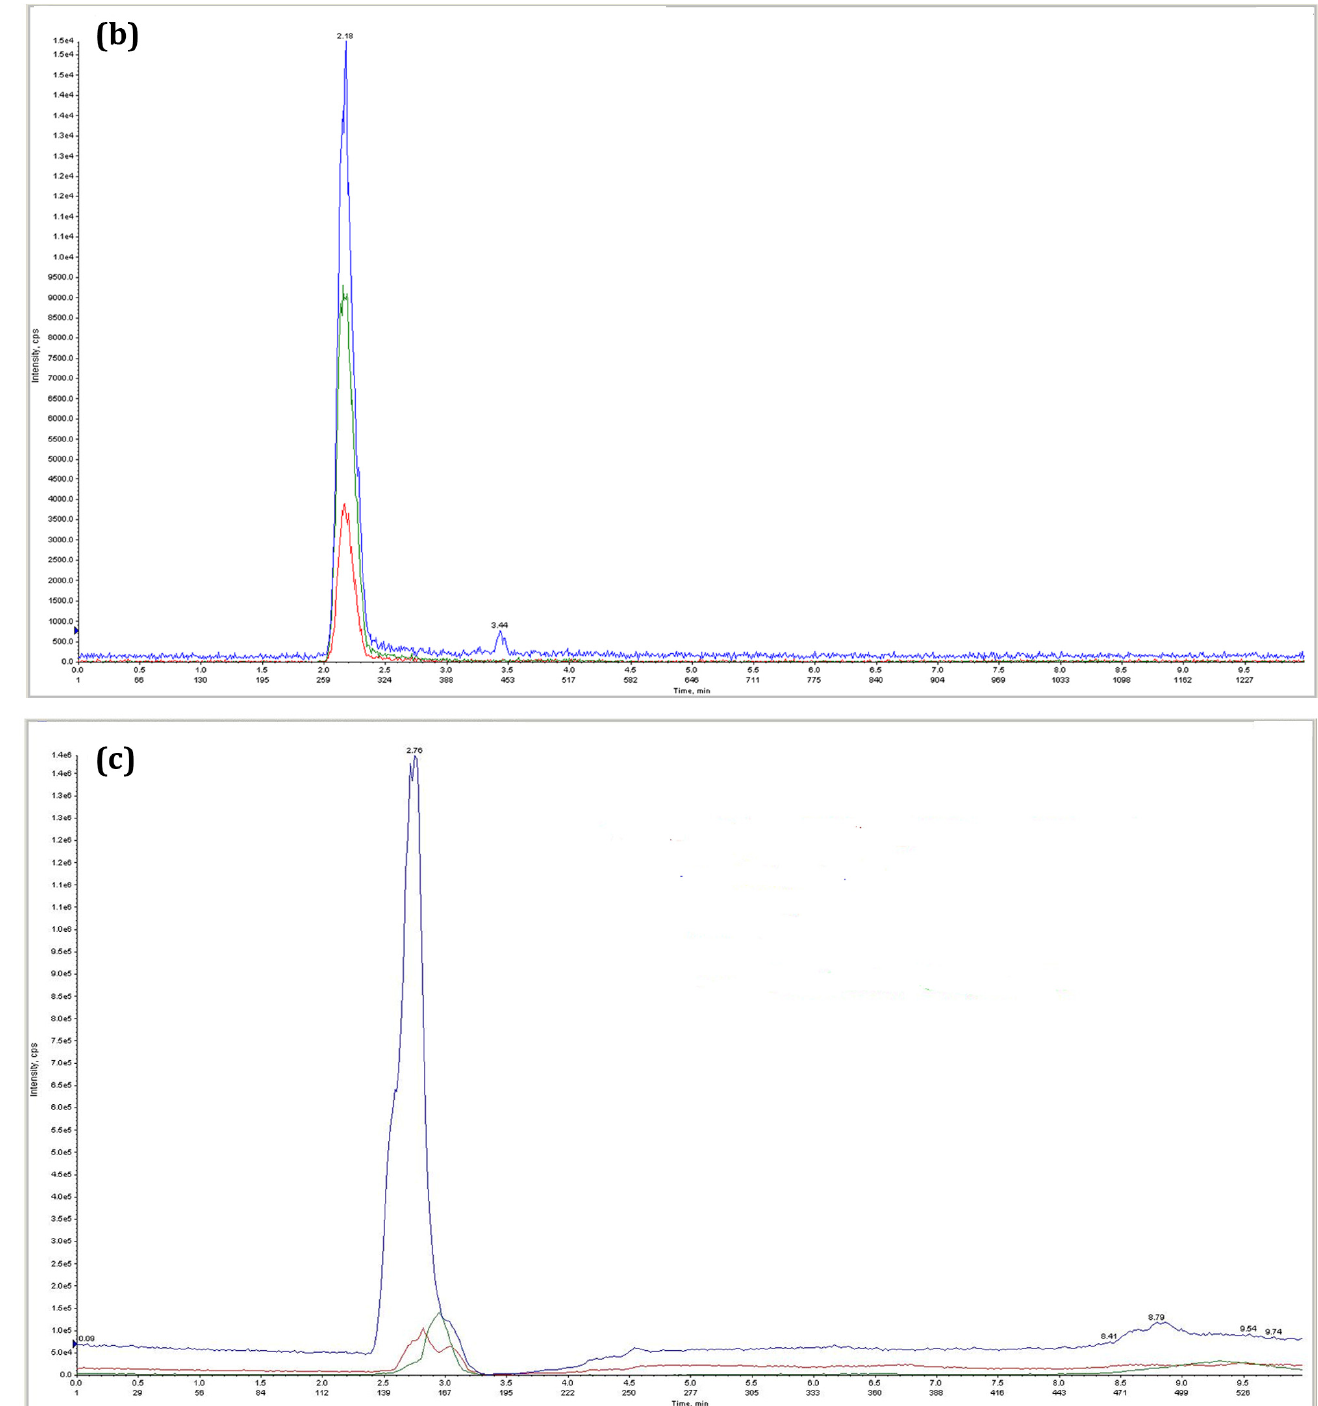
Figure 4. Retention analysis in HPLC: ( a ) elution chromatogram of ATP; time interval: 2.3 to 3.3. ( b ) Elution chromatogram of streptomycin; time interval: 2.0 to 2.50. ( c ). Elution chromatogram of adenylated streptomycin; time interval: 2.40 to 3.30.